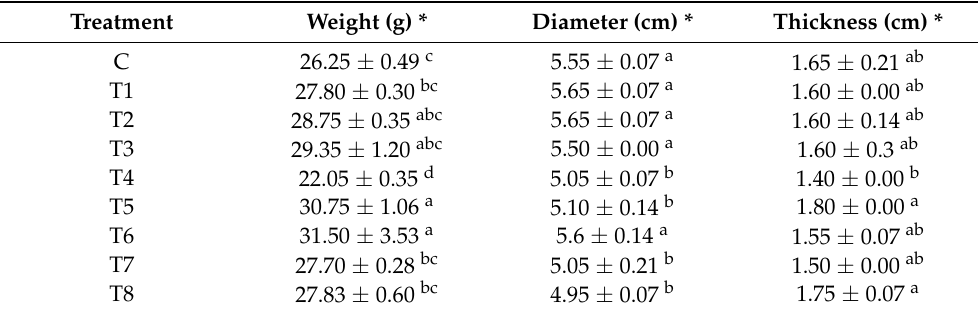
Table 6. The mean value of weight, diameter and thickness of different gluten-free cinnamon roll treatments and